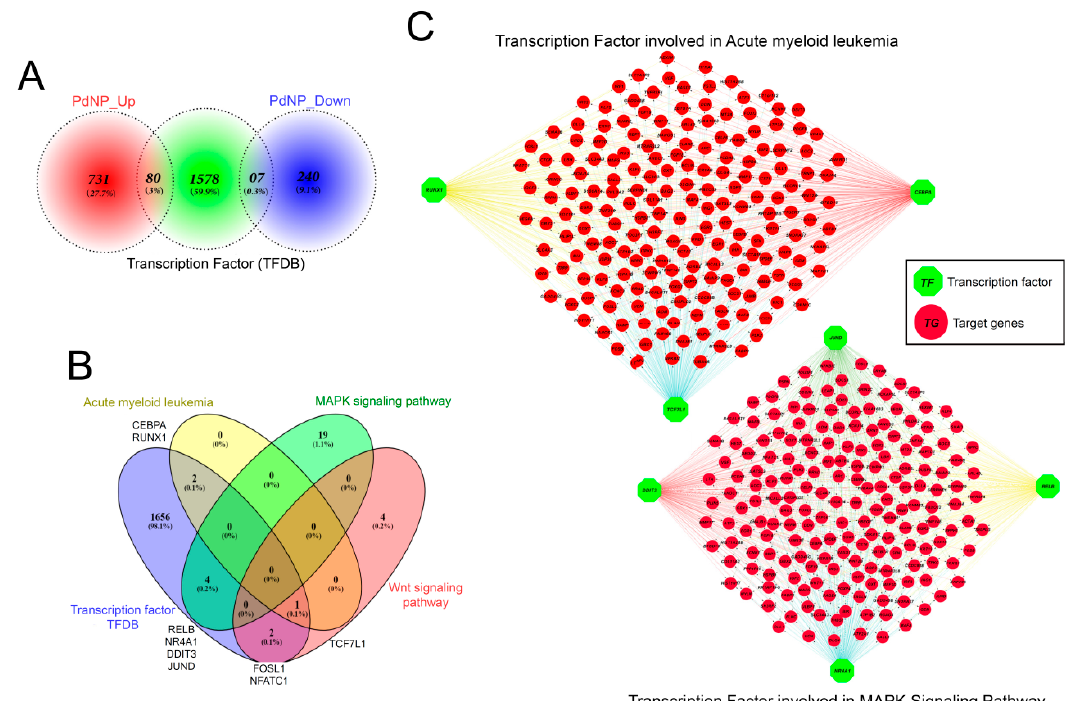
Figure 12. Discovery of critical transcription factors that directly regulate identified differentially expressed genes (DEGs) in palladium nanoparticle (PdNPs)-treated SKOV3 cells. ( A ) Ven diagram showing the number of transcription factors (TFs) among the DEGs. ( B ) Ven diagram showing the number of transcription factors identified when 80 upregulated TF genes were submitted to KEGG pathway analysis. Note that TFs acting in acute myeloid leukemia, MAPK signaling, and Wnt signaling pathways were significantly altered. ( C ) Gene network showing the interconnectedness of DEGs directly regulated by TFs such as RUNX1 , TCF7L1 , CEBPA , JUND , DDIT3 , RELB , and NR4A1 .